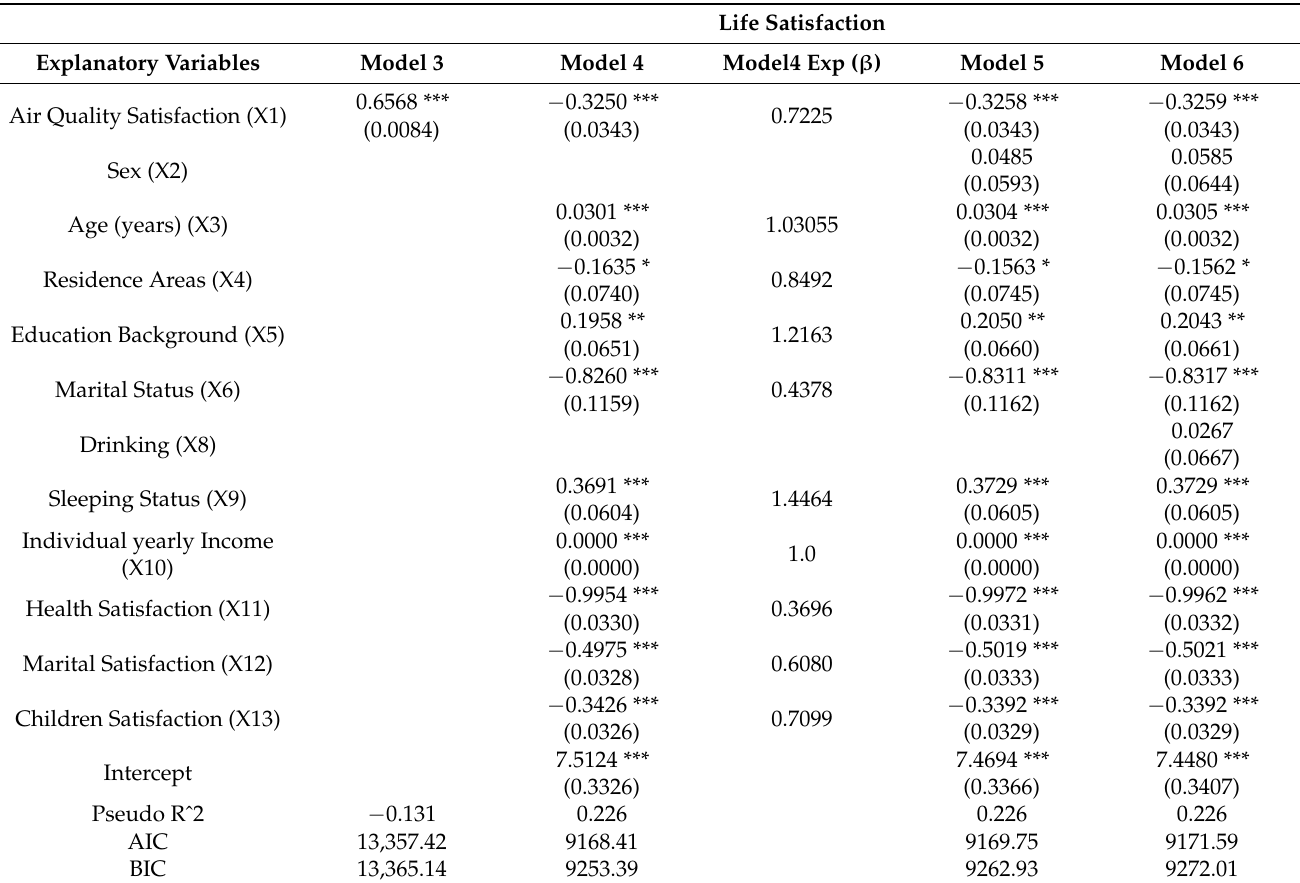
Table 5. Binomial logistic regression analysis of factors influencing experienced utility ( n =